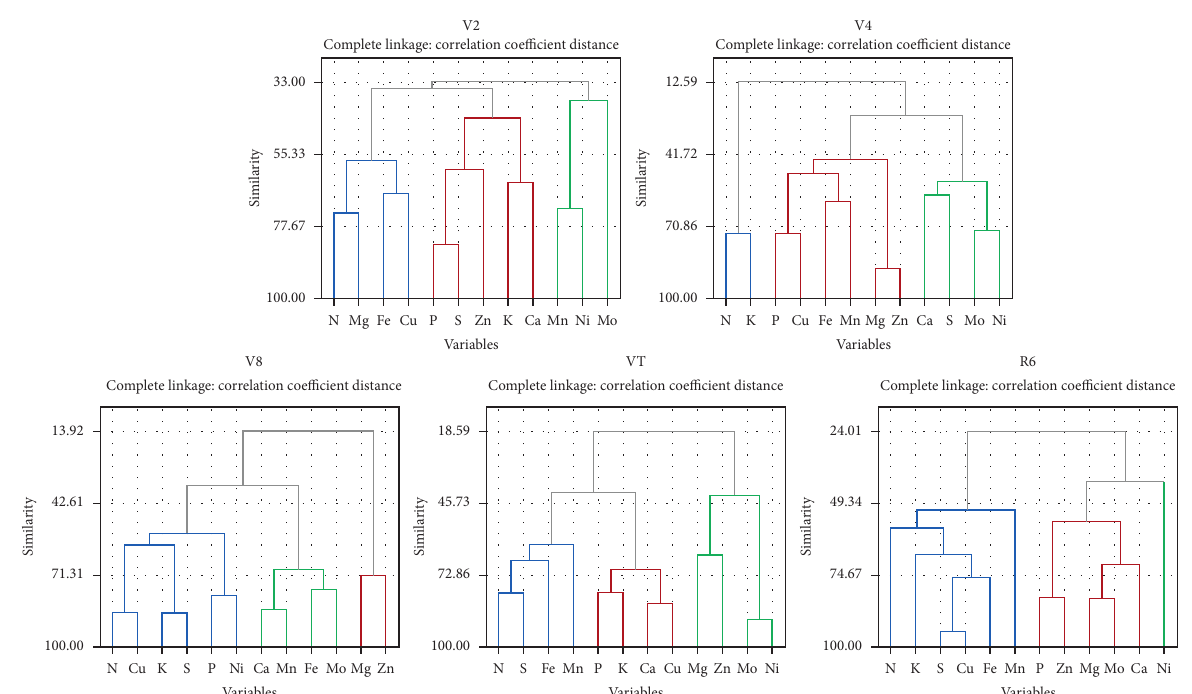
Figure 2: Cluster of sampling times in nutrients with means of NPK on leaves. Nitrogen (N), potassium (K), phosphorus (P), magnesium (Mg), calcium (Ca), sulphur (S), zinc (Zn), iron (Fe), copper (Cu), manganese (Mn), nickel (Ni), and molybdenum (Mo).